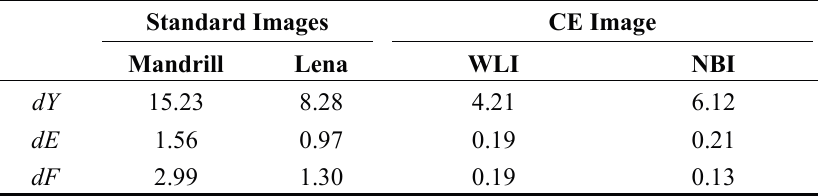
Table 2. AVG. Absolute difference in consecutive pixel